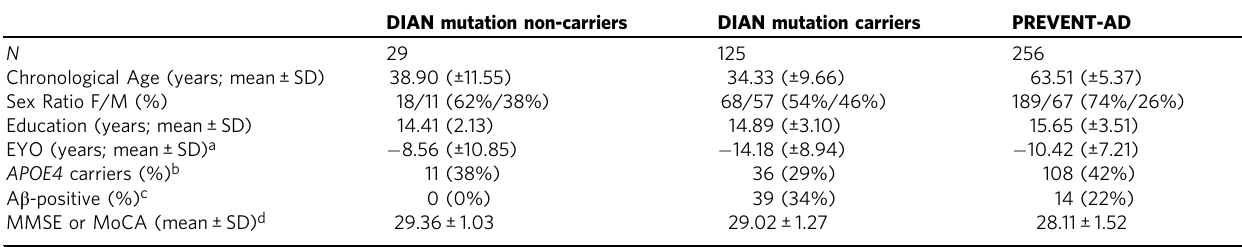
Table 2 DIAN and PREVENT-AD test set